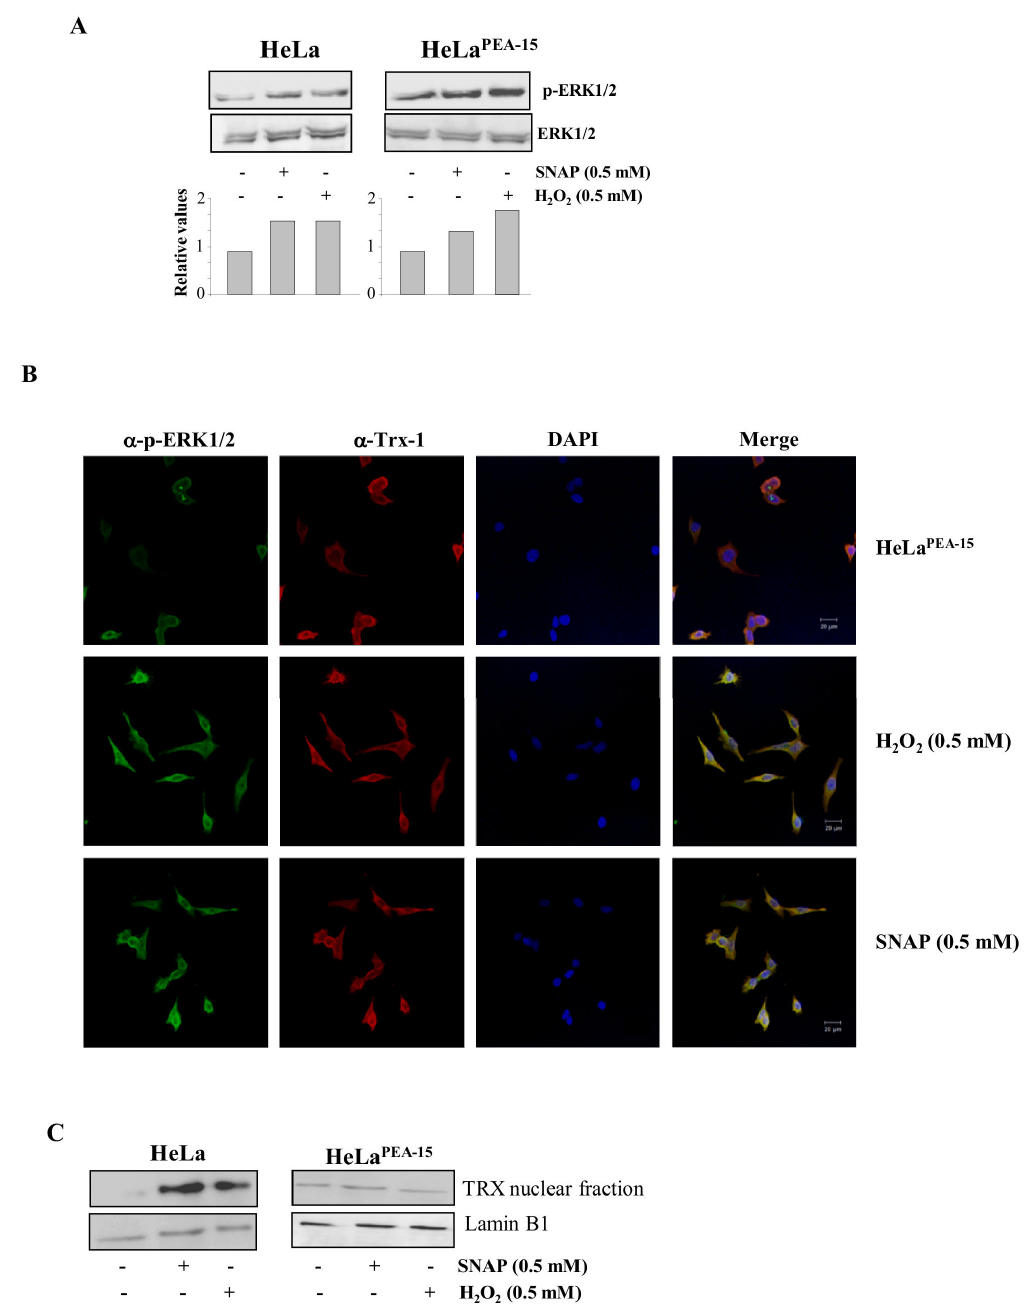
Figure 3. Stress-induced sub-cellular localization and activation of TRX-1 and phospho ERK 1/2 MAP Kinases in HeLa cells expressing PEA-15. ( A ) HeLa cells and HeLa cells expressing PEA-15 were incubated with SNAP (0.5 mM) or H mM) for 2 h at 37°C. Cells were lysed and phosphorylation of the ERK1/2 MAP kinases was examined by western blotting. Western blot results are representative of four independent experiments. Histogram represents the ratio between the densitometric values of the protein bands corresponding to the phosphorylated form and of the total ERK 1/2 MAP kinases (Lower panel). ( B ) HeLa cells expressing PEA-15, were treated with SNAP (0.5 mM), or H phospho-ERK 1/2 MAP Kinases was performed as described in Materials and Methods. Bar = 20µm. (C) HeLa cells and HeLa cells expressing PEA-15 were incubated with SNAP (0.5 mM) or H Western blotting with the anti-human TRX-1 mouse monoclonal antibody. Western blot results are representative of three independent experiments. doi: 10.1371/journal.pone.0084588.g003 PLOS ONE |